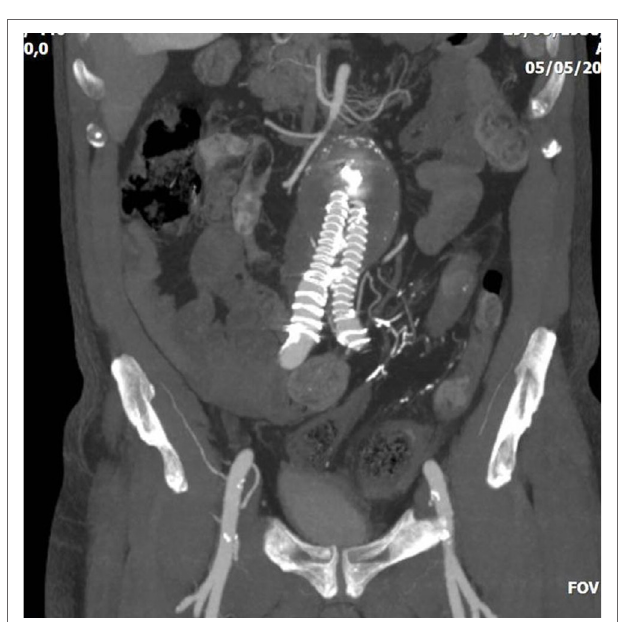
FiGURe 3 | Abdominal CT of a 75-year-old patient who underwent endovascular abdominal aortic aneurysm repair with a covered aortic stent-graft. The patient had a type II endoleak via inferior mesenteric artery, and was treated with direct puncture and embolization with glue. Later, the patient presented severe colonic ischemia with sepsis. Embolic material is evident in the inferior mesenteric artery, whereas the sigmoid colon appears with thickened necrotic wall.